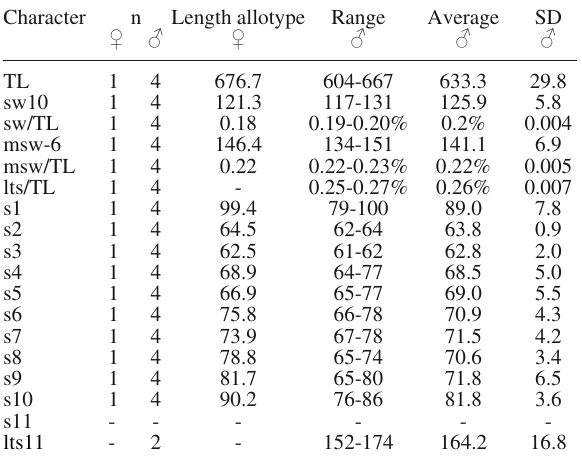
t able 1. – Measurements (µm) of adult Pycnophyes pardosi n. sp.; lts, lateral terminal spine; msw-6, maximum standard width of